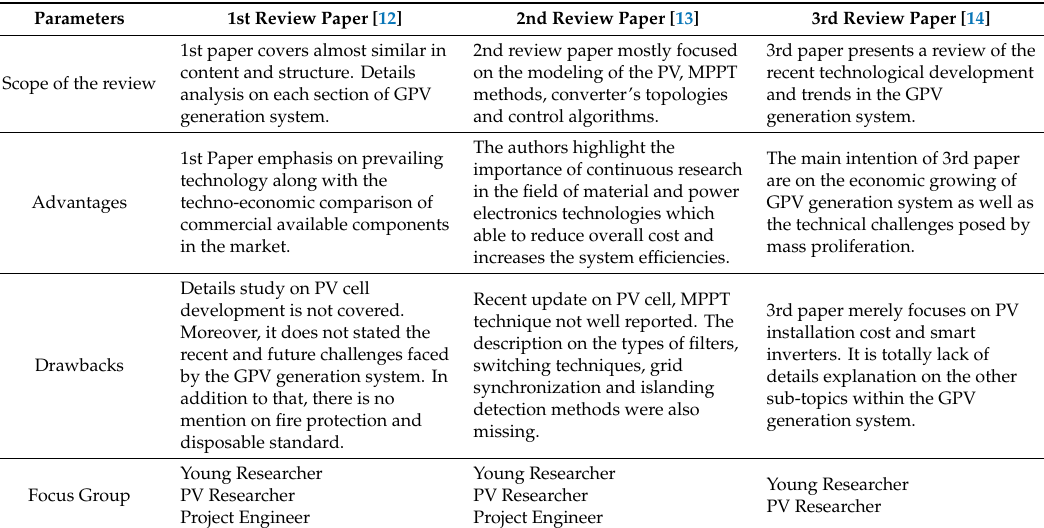
Table 1. Comparative analysis of review papers covers a similar